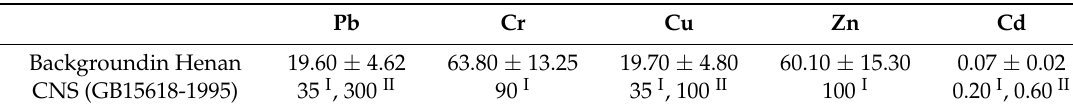
Table 1. CNS and Henan background value of HMs (mg · kg − 1